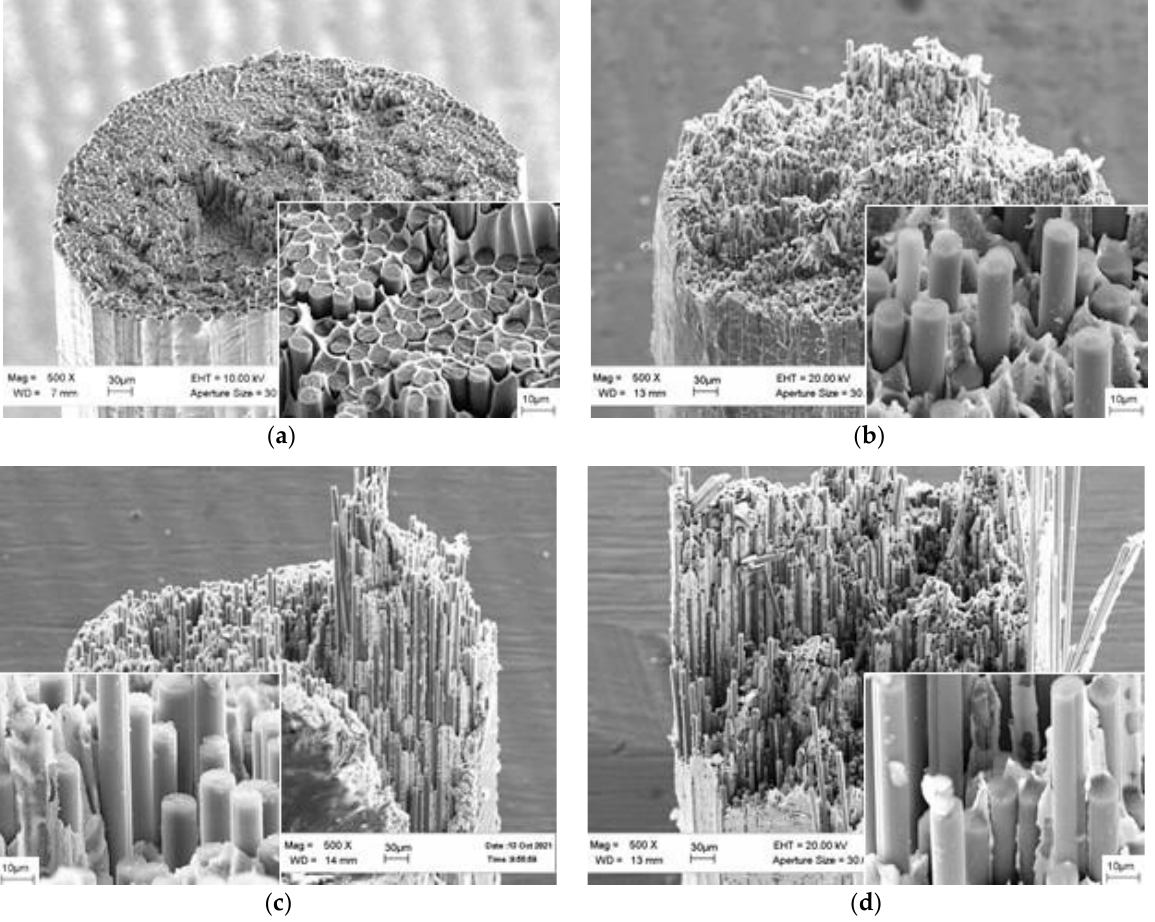
Figure 4. Fracture surfaces of a CF/Al-Sn composite with tin content from 0 to 50 at.%: ( a ) 0% Sn, ( b ) 10% Sn, ( c ) 25% Sn, ( d ) 50% Sn.